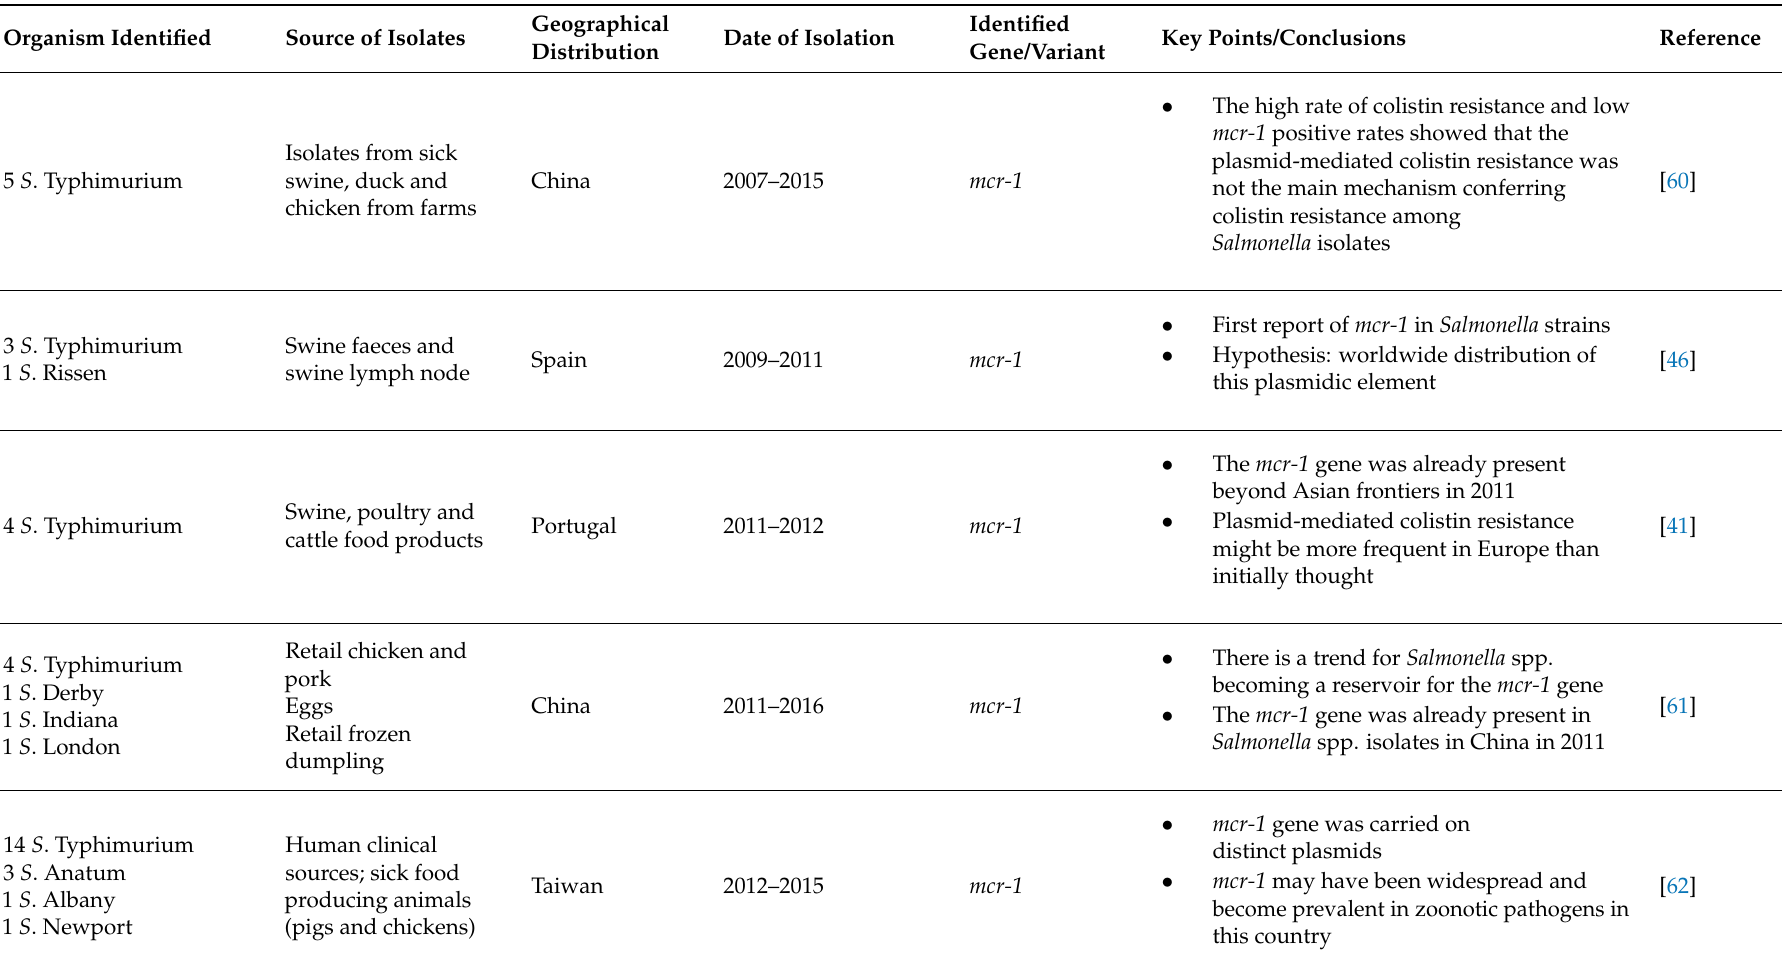
Table 1. Reports of mcr -like genes identified in Salmonella enterica